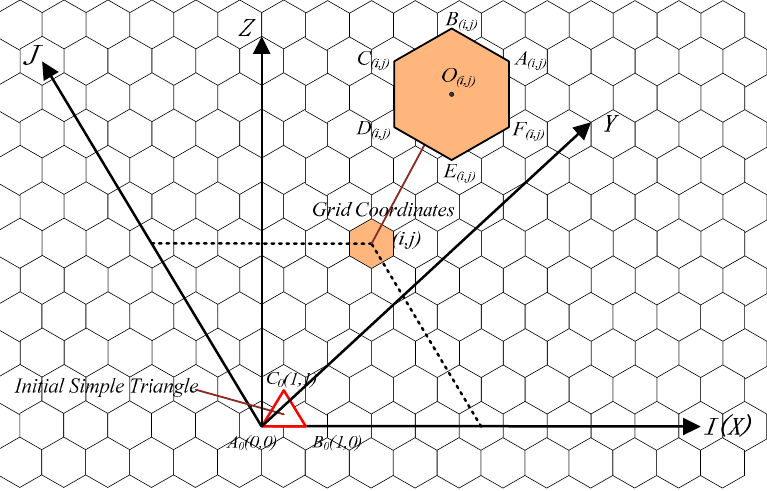
Figure 4. The definition of the extended grid skew coordinate system and the spatial Cartesian coordinate system.